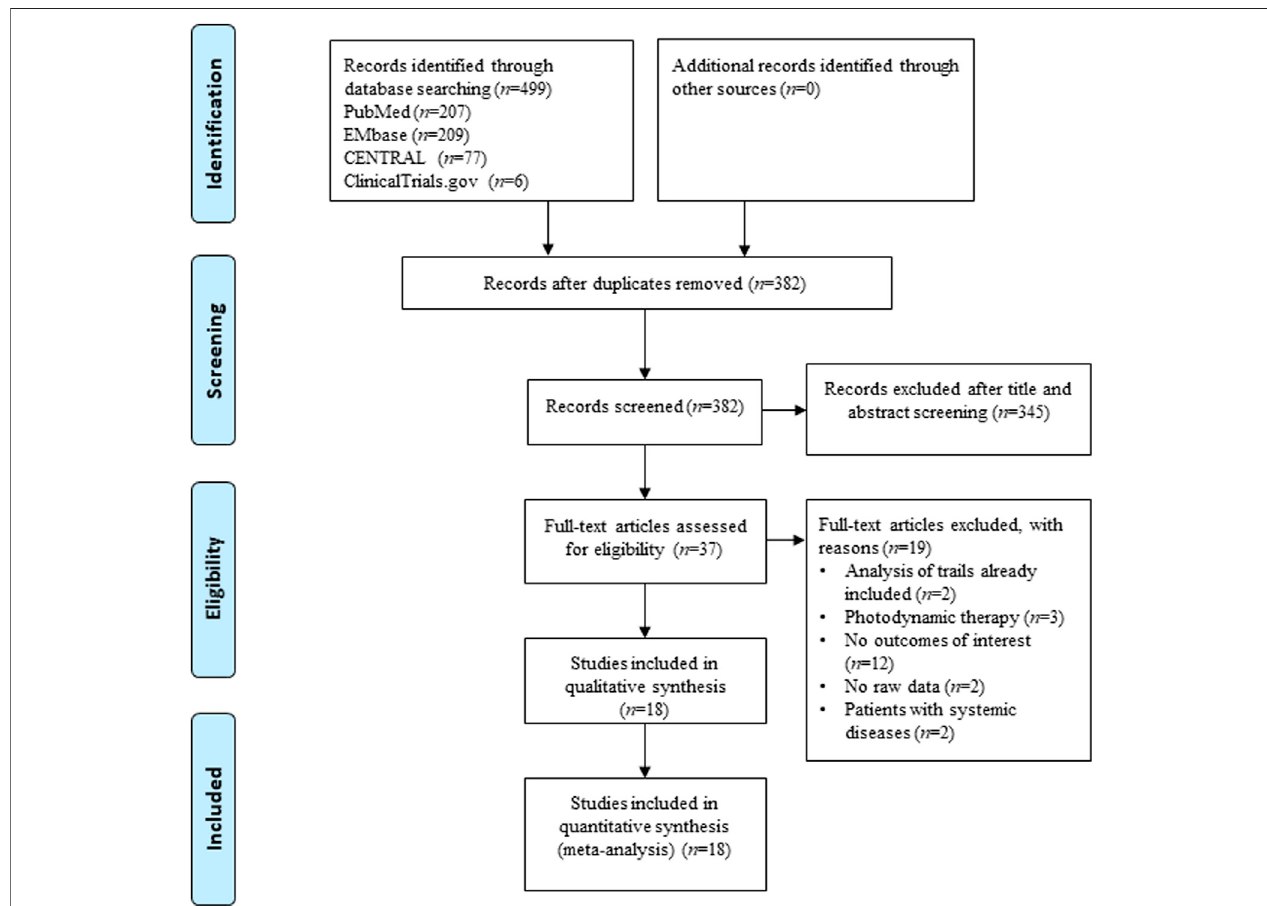
FIGURE 1 | Flow diagram of literature